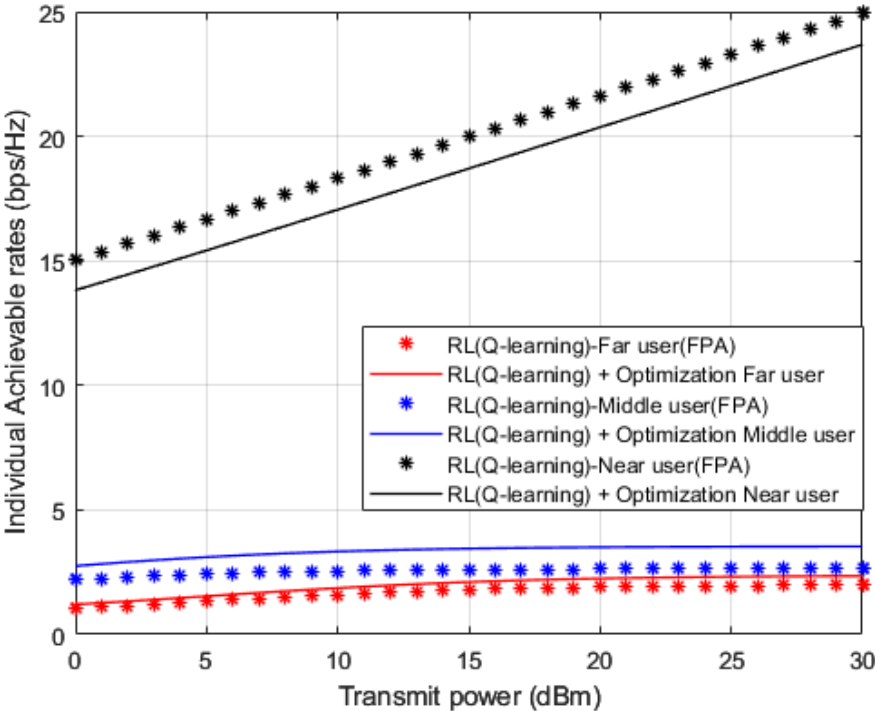
Figure 15. Individual rate vs. Power ( Q ‐ learning, Optimization,